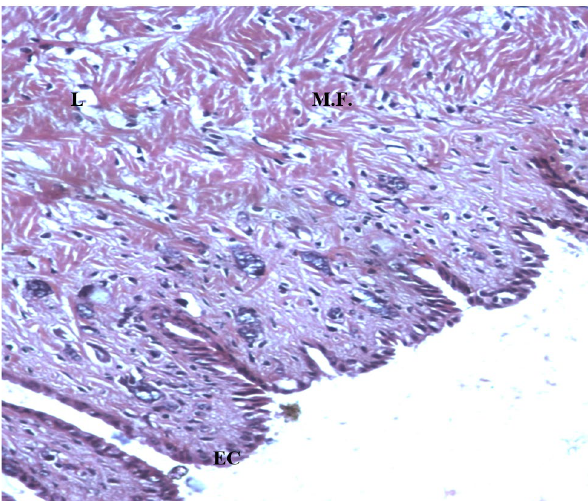
Fig. 1. Histological section of Helix pomatia snail in July. Magnification 10×/0.25. L – lumen, M.F. – muscle fibers, E.C. – epithelial